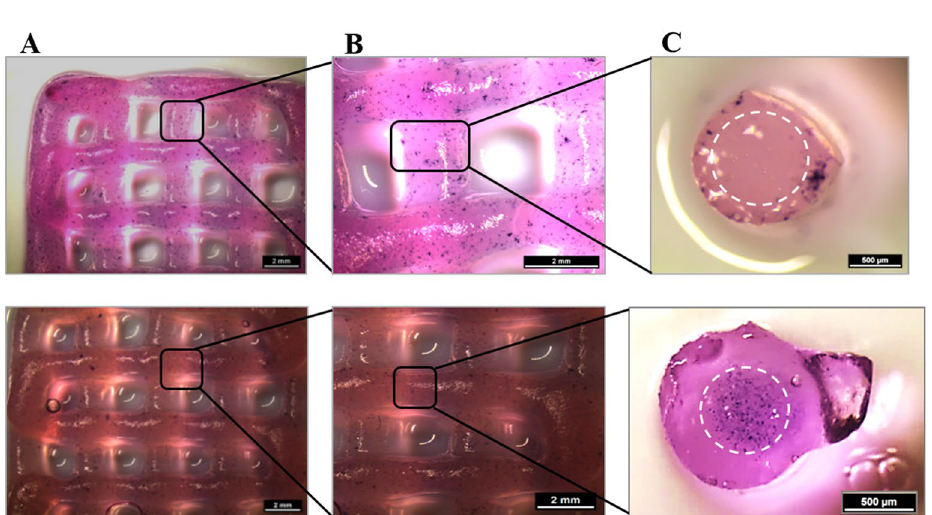
Figure 8. Metabolic activity at day 7 of cultivation (via MTT stain; violet) of HepG2 and NIH 3T3 cells embedded in core–shell printed hydrogel scaffolds; the core–shell interface is visualized via white dashed lines in C . Upper tile shows HepG2 encapsulated in the shell compartment consisting of algMC + Matrigel whereas the core remained cell free. Lower tile shows NIH 3T3 cells encapsulated in the core compartment consisting of algMC whereas the shell remained cell-free. ( A , B ) Scale bars 2 mm. ( C ) Scale bars 500